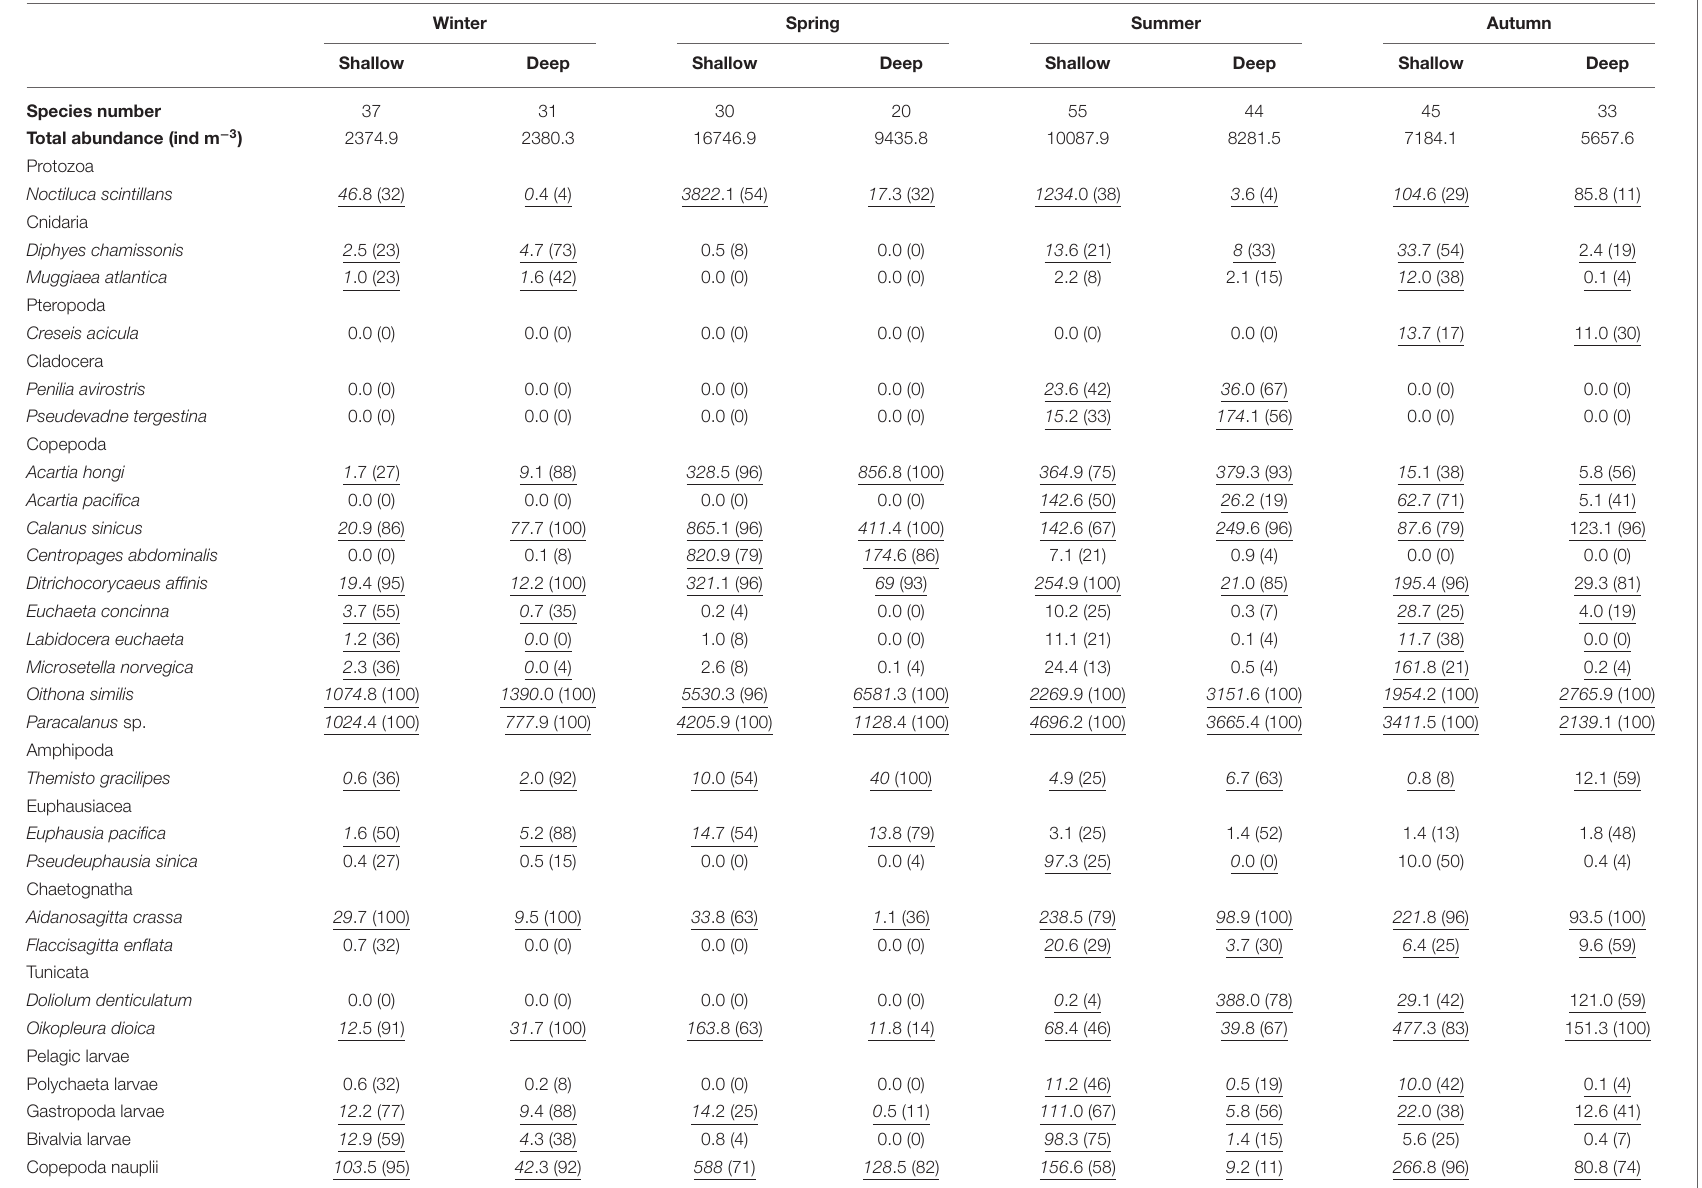
TABLE 2 | Average abundances (ind m − 3 ) of zooplankton species that contributed > 2% to community dissimilarities between domains (underlined numbers) and species number identified in the shallow and deep regions during four seasons in the Yellow Sea.